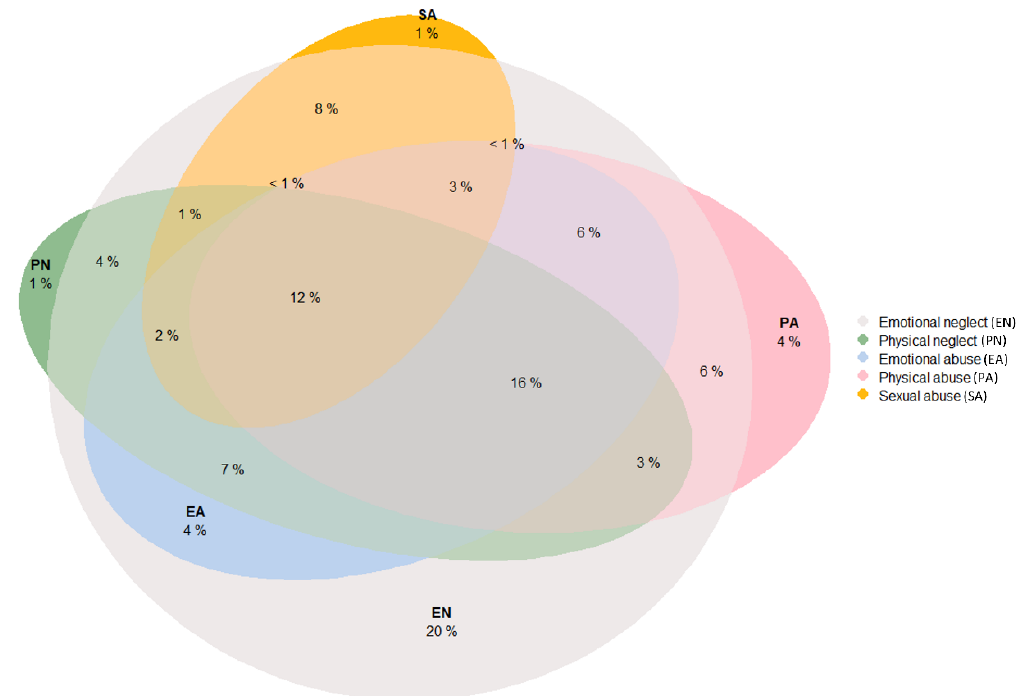
Figure 2. Overlap of childhood maltreatment (CM) subtypes in our sample. As can be seen, participants with a history of CM had rarely been exposed to only one type of CM. The form of CM that most often occurred in isolation was emotional neglect, accounting for 20% of the youths exposed to CM (although 94% of participants exposed to CM reported emotional neglect). Only 6% of the youth with a history of CM reported in isolation physical neglect, physical abuse or sexual abuse. Meanwhile, 74% of the individuals reported multiple forms of CM. Specifically, 16% reported four CM subtypes: emotional neglect, physical neglect, emotional abuse, and physical abuse. Furthermore, 12% of the children and adolescent exposed to CM manifested having suffered all five forms of CM, including sexual abuse.